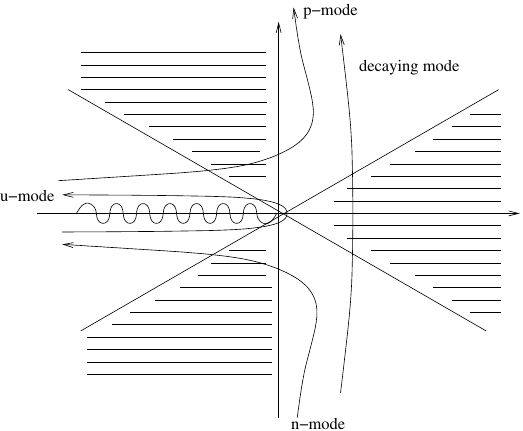
Figure 2. Paths used in the subluminal case in Corley’s work [8]. Given the universality of (5), this diagram holds true for all the subluminal cases, which can be rewritten in terms of the Orr– Sommerfeld-like equation discussed in [1]. The paths for the dispersive modes, called the p -mode and the n -mode in the text, are indicated, as well as the one for the Hawking mode ( u -mode) and for the decaying mode. The last mode is the one in the black hole region x < 0. As remarked by Corley [8], the path for the decaying mode can be deformed in the paths for the Hawking particle and for the dispersive modes. For the superluminal case, we refer the reader to Figure 1 displayed in [2]. For the Hawking mode at frequency ω , one obtains (cf.